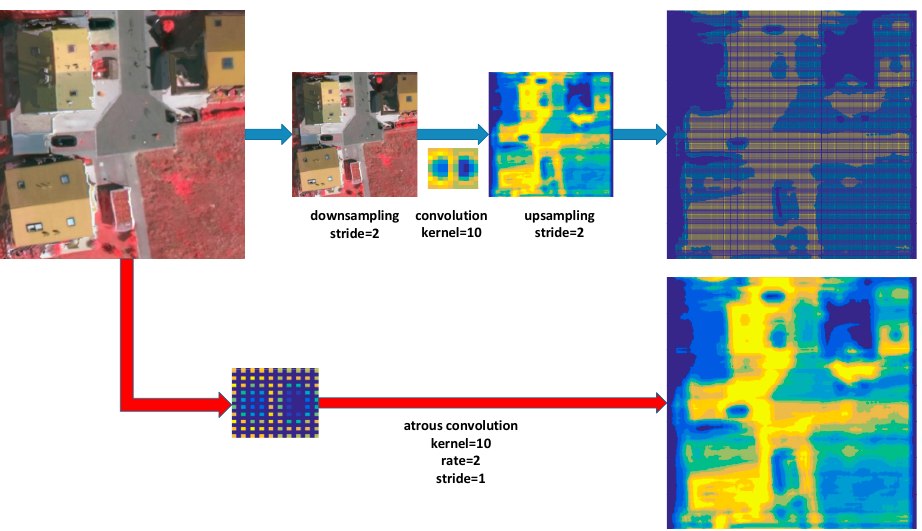
Figure 6. Illustration of atrous convolution. Blue arrows show a standard convolution performed on a low-resolution feature map. Red arrows show a dense feature map generated using atrous convolution with rate r = 2 on a high-resolution input feature map.